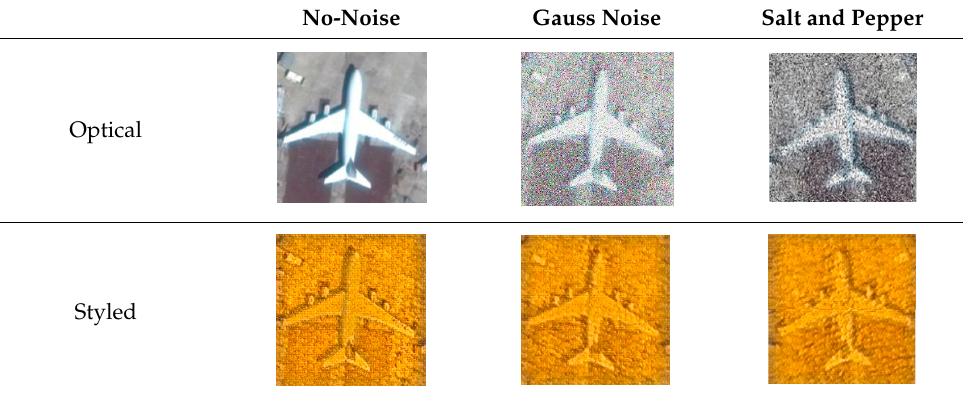
Table 9. Noises and style transfer image.